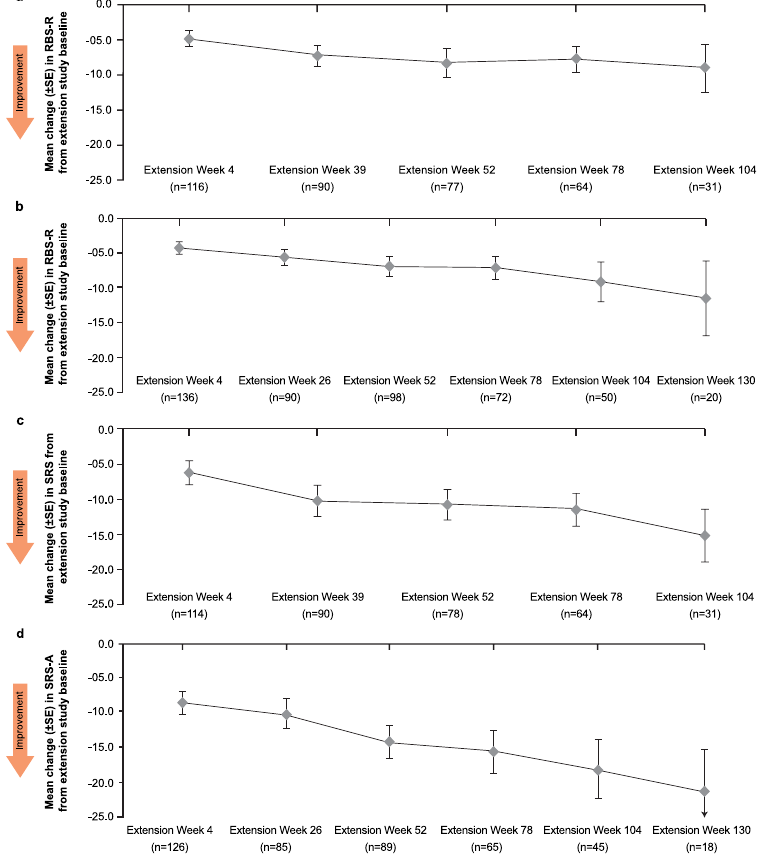
Figure 3. RBS-R score from extension study baseline in ( a ) adolescents and ( b ) adults * and SRS score from extension study baseline in ( c ) adolescents and ( d ) adults * . RBS-R, Repetitive Behavior Scale – Revised; SE, standard error; SRS, Social Responsiveness Scale. * All patients regardless of methylation